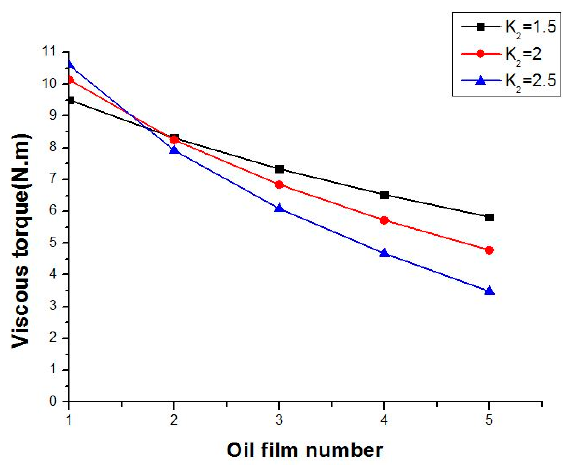
Figure 7. Viscous torque distribution with different K 2 .